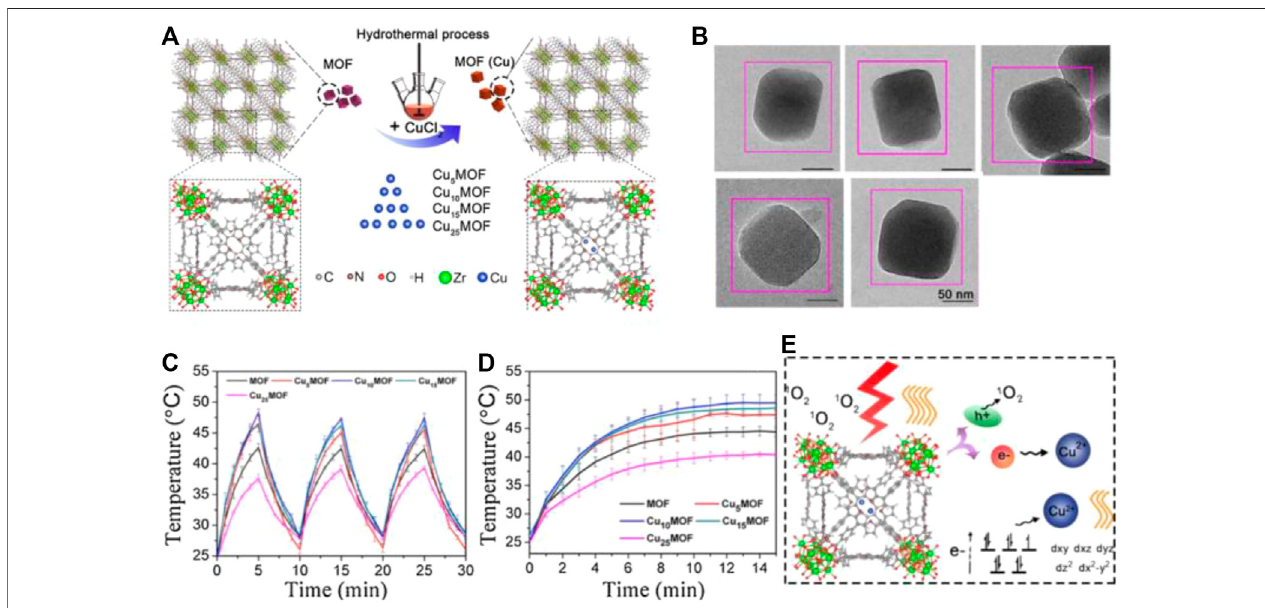
FIGURE 5 | (A) Schematic diagram of the preparation of copper MOF material. (B) TEM images. (C) Heating and cooling curves of copper MOF materials under light. (D) LightandheatcurvesofMOFmaterialswithdifferentcoppercontent,Cu 5 MOF,Cu 10 MOF,andCu 15 MOF,Cu 25 MOF. (E) Schematicdiagramofthemechanism of copper MOF material improving photocatalysis and photothermal effect. Reproduced with permission (Han et al., 2020). Copyright 2020, Applied Catalysis B: